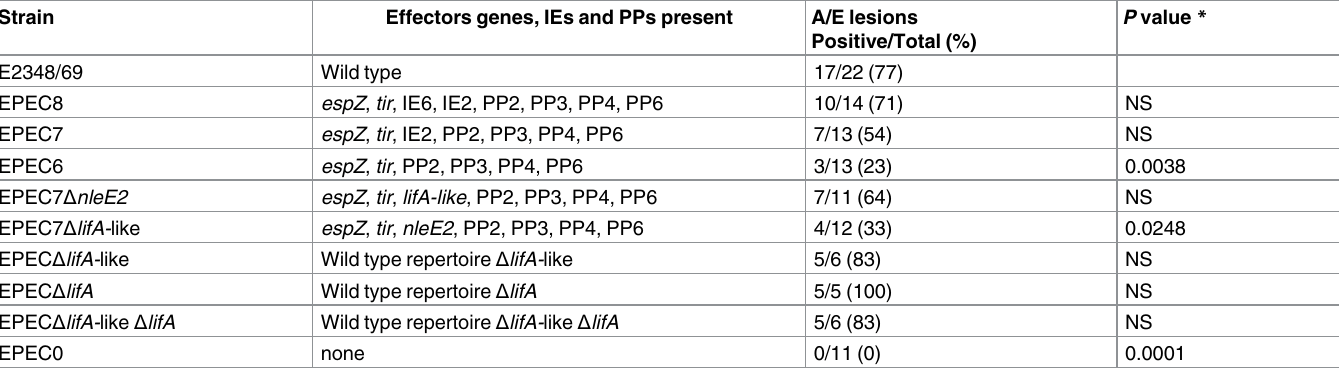
Table 3. A/E lesions formation by EPEC deletion mutants in IE